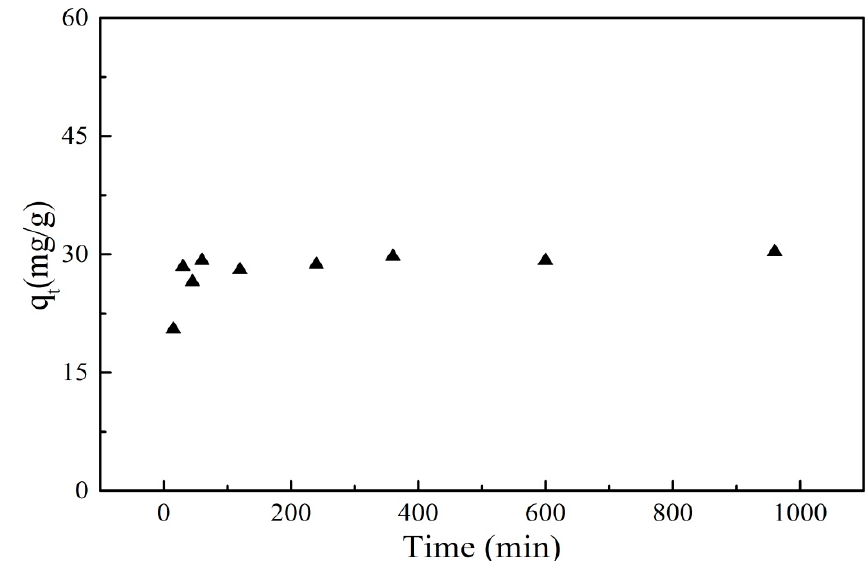
Figure 7. E ff ect of contact time on the adsorption of PRO onto GO / Fe 3 O 4 ( C 0 = 25 mg / L, V = 20 mL, m Figure 7. Effect of contact time on the adsorption of PRO onto GO/Fe 3 O 4 ( C 0 = 25 mg/L, V = 20 mL, m = 0.01 g, pH = 7.5). = 0.01 g, pH = 7.5).